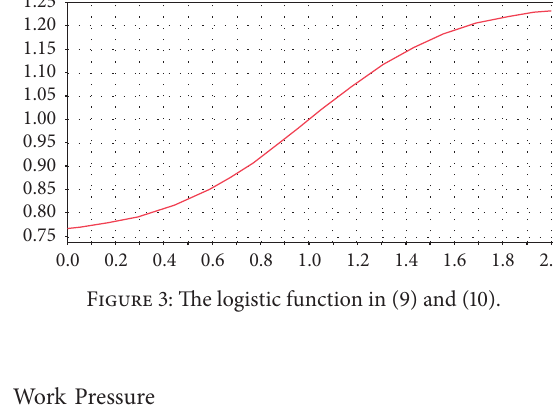
Figure 3: The logistic function in (9) and